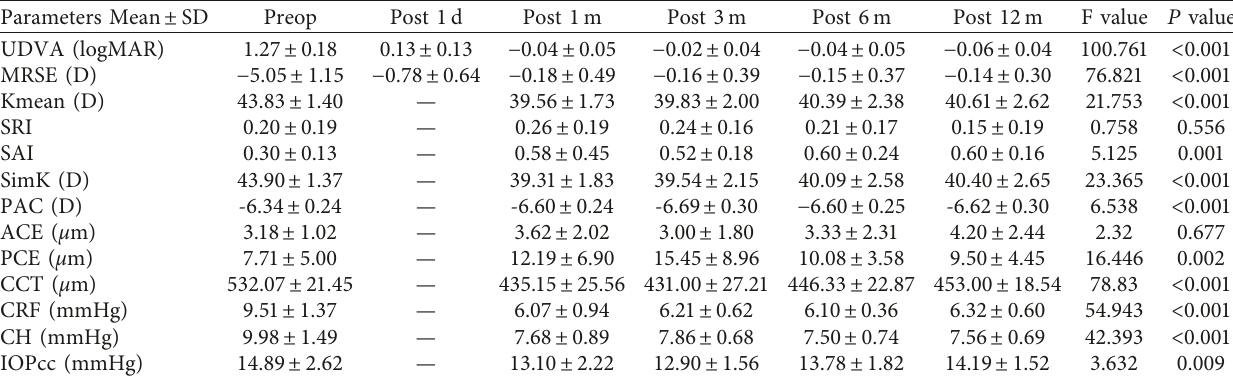
Table 2: Changes in visual acuity, refraction, corneal morphology, and corneal biomechanics over